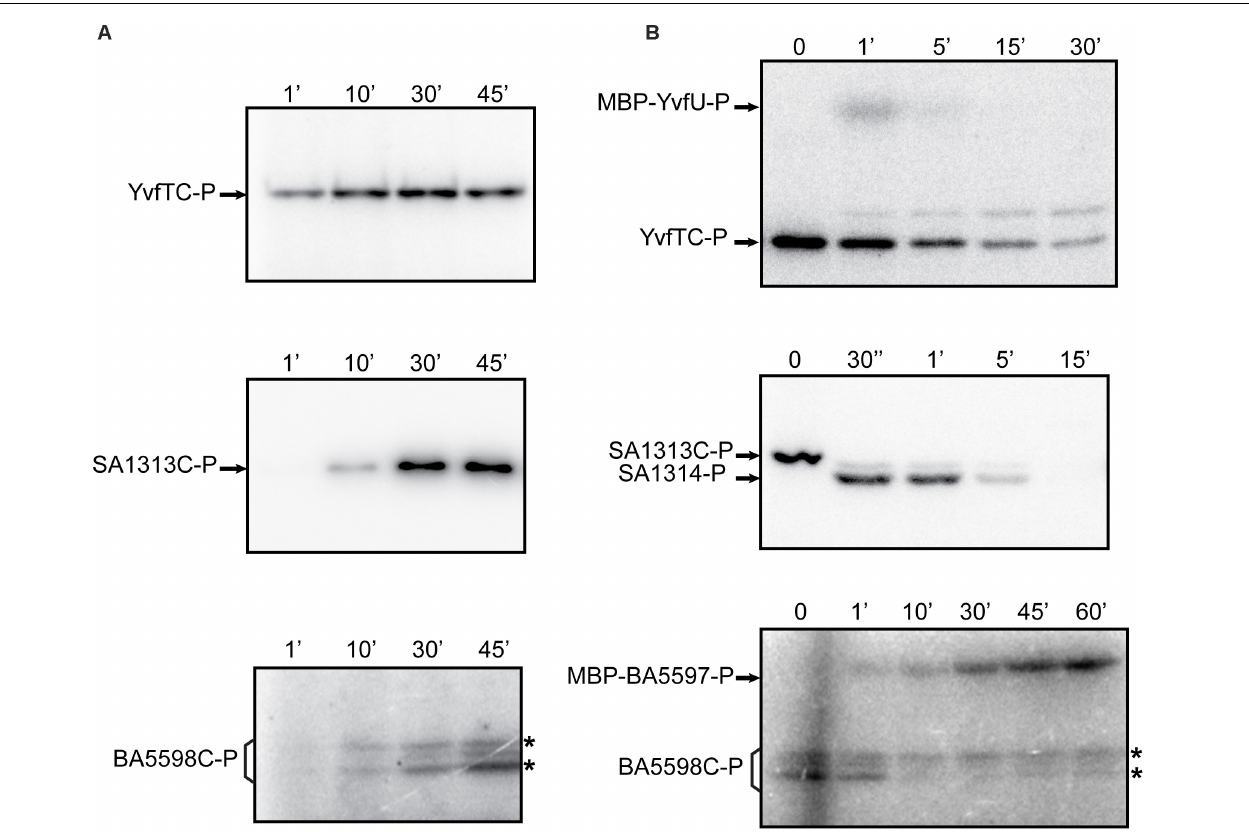
FIGURE 3 | (A) Autophosphorylation assay of YvfTC, BA5598C, and SA1313C. The purified cytosolic domains were incubated with R buffer at room temperature. Reaction was initiated by the addition of [ γ − 32 P] ATP. In the case of BA5598C, western blot analysis with anti-DesKC polyclonal antibodies showed that both bands marked with * correspond to the protein, while anti-His antibodies indicated that only the upper one possesses the 6xHis-tag (data not shown) (B) HKs phosphotransfer assay to cognate RRs. After 30 min of autophosphorylation at room temperature, each HK was mixed with an equimolar amount of its each cognate RR. After SDS-PAGE, gels were dried, exposed to a radioactive storage screen and analyzed using an Amersham Biosciences Molecular Dynamics TyphoonTM FLA 7000 scanner. Pictures are representative of at least three independent